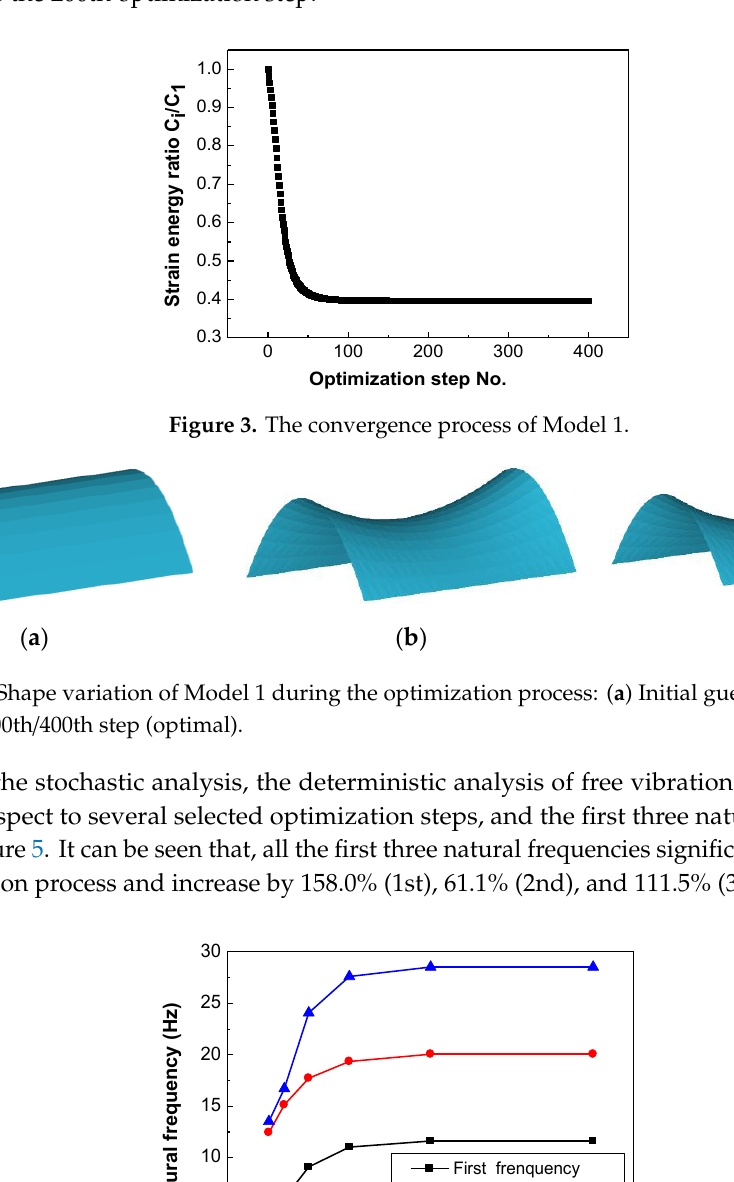
Figure 5. Evolution of the first three natural frequencies of Model 1 during the optimization process.